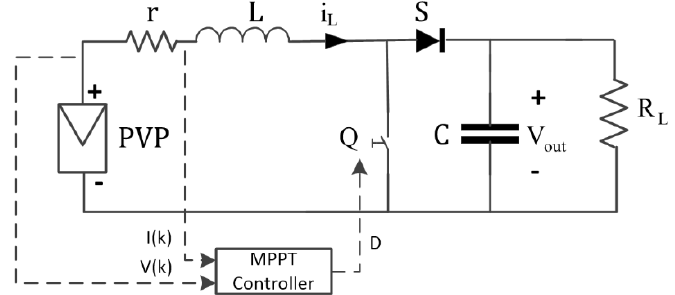
Figure 5. Diagram of the PVS with the maximum power point tracking (MPPT) controller.